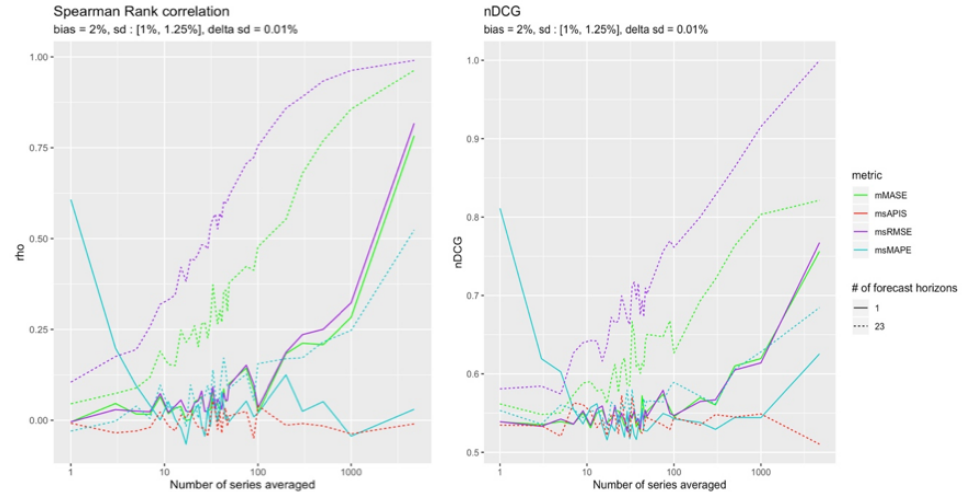
Figure 11. Spearman Rank correlation and nDCG for ( + + − ) configuration.